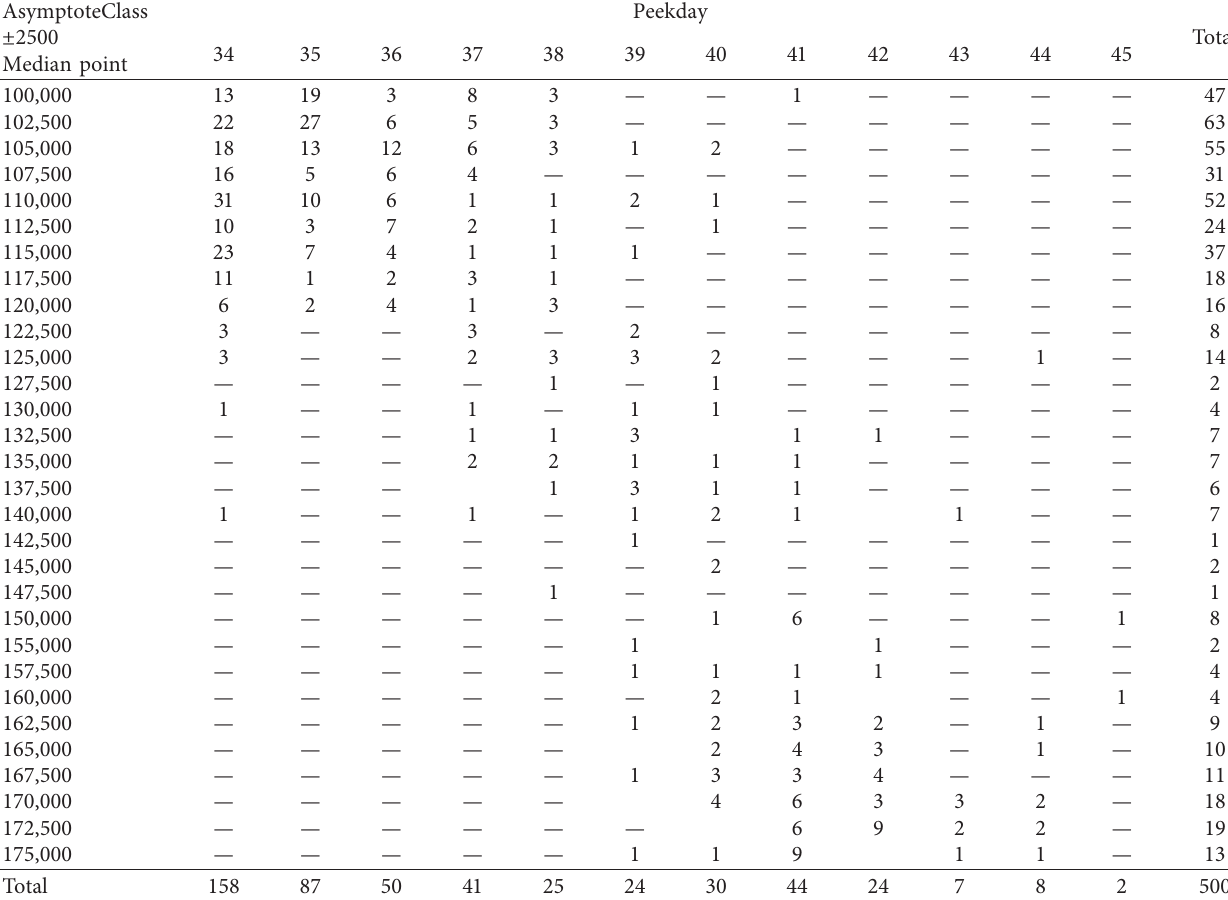
Table 1: COVID-19 bootstrap (AsymptoteClass, Peekday)